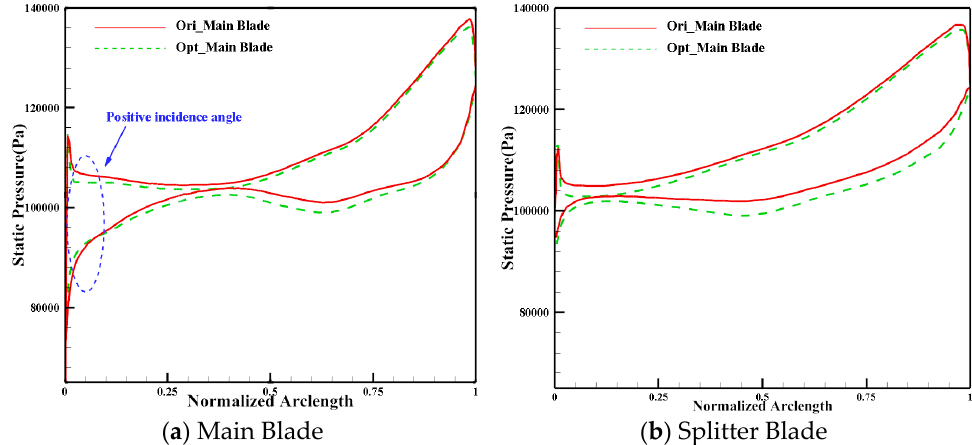
Figure 18. Comparison of the static pressure distribution on the blade surface at 80% height before and after optimisation (common operating condition).